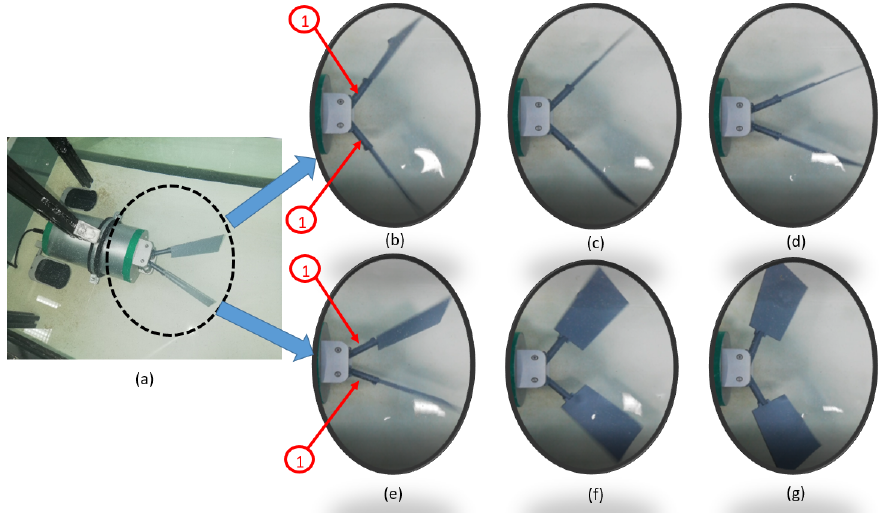
Figure 2. A BUUV ( a ) with subsequent phases of movement: ( b – d ) power stroke and ( e – g ) return stroke; 1—additional